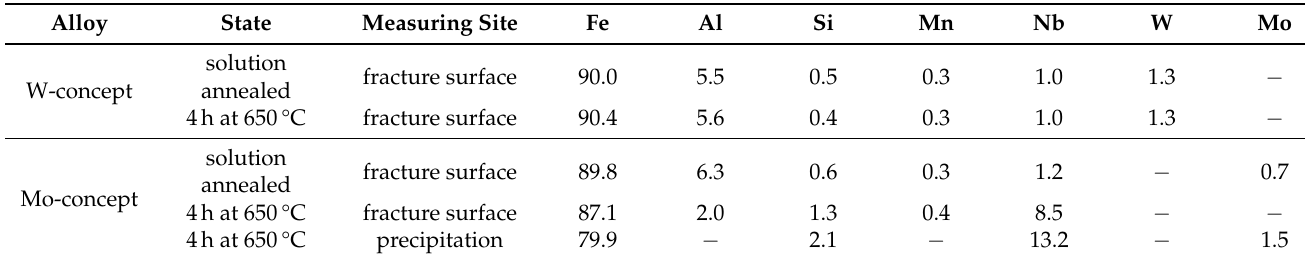
Table 4. Chemical composition (wt.%) analyzed by EDS at different measuring sites of the fracture surfaces shown in Figure